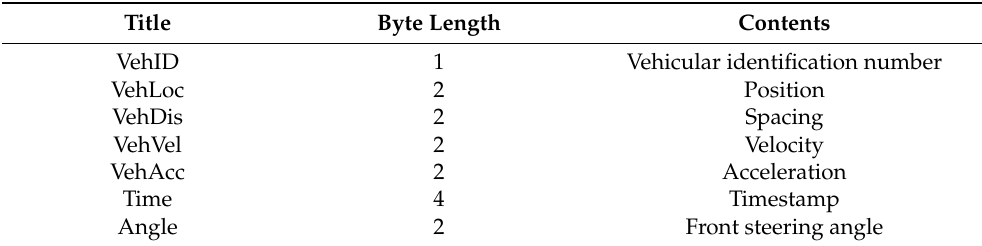
Table 1. V2X communication protocols of the cooperative car-following system.